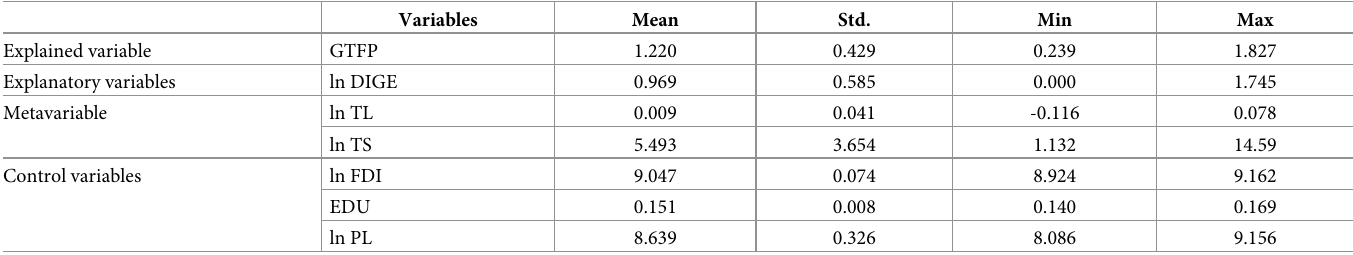
Table 4. Descriptive statistics of